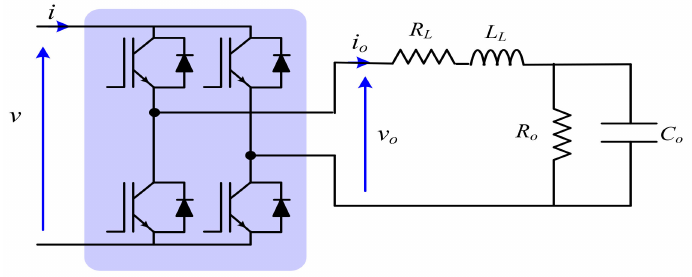
Figure 11. Load configuration for the experimental